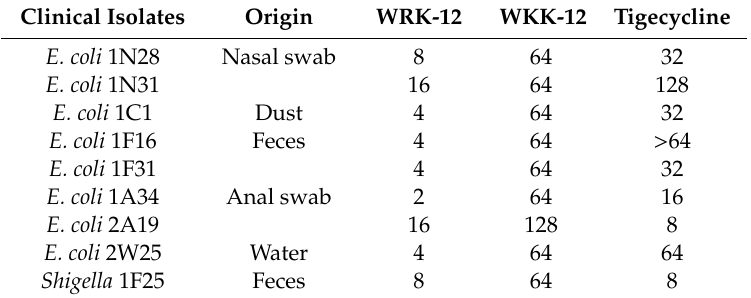
Table 3. Antibacterial activity of amphiphilic peptides against tigecycline-resistant clinical isolates (MIC, µ g /